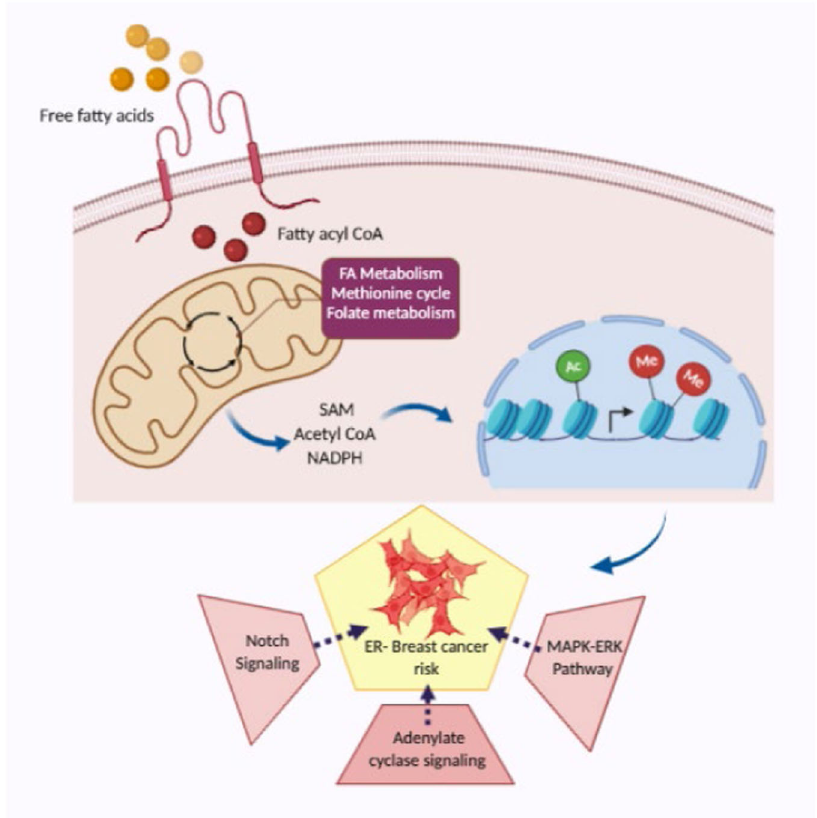
Fig. 7 Proposed model illustrating the orchestration of lipid-induced molecular changes. Sensors : Senses the fatty acid-rich environment and perturb cellular metabolism providing the essential substrate for histone modi fi cations and thereby turning on the Mediators- histone PTMs, which consequently activates the Effectors- Notch, adenylate cyclase, and MAPK-ERK the key protein signaling associated with ER − breast